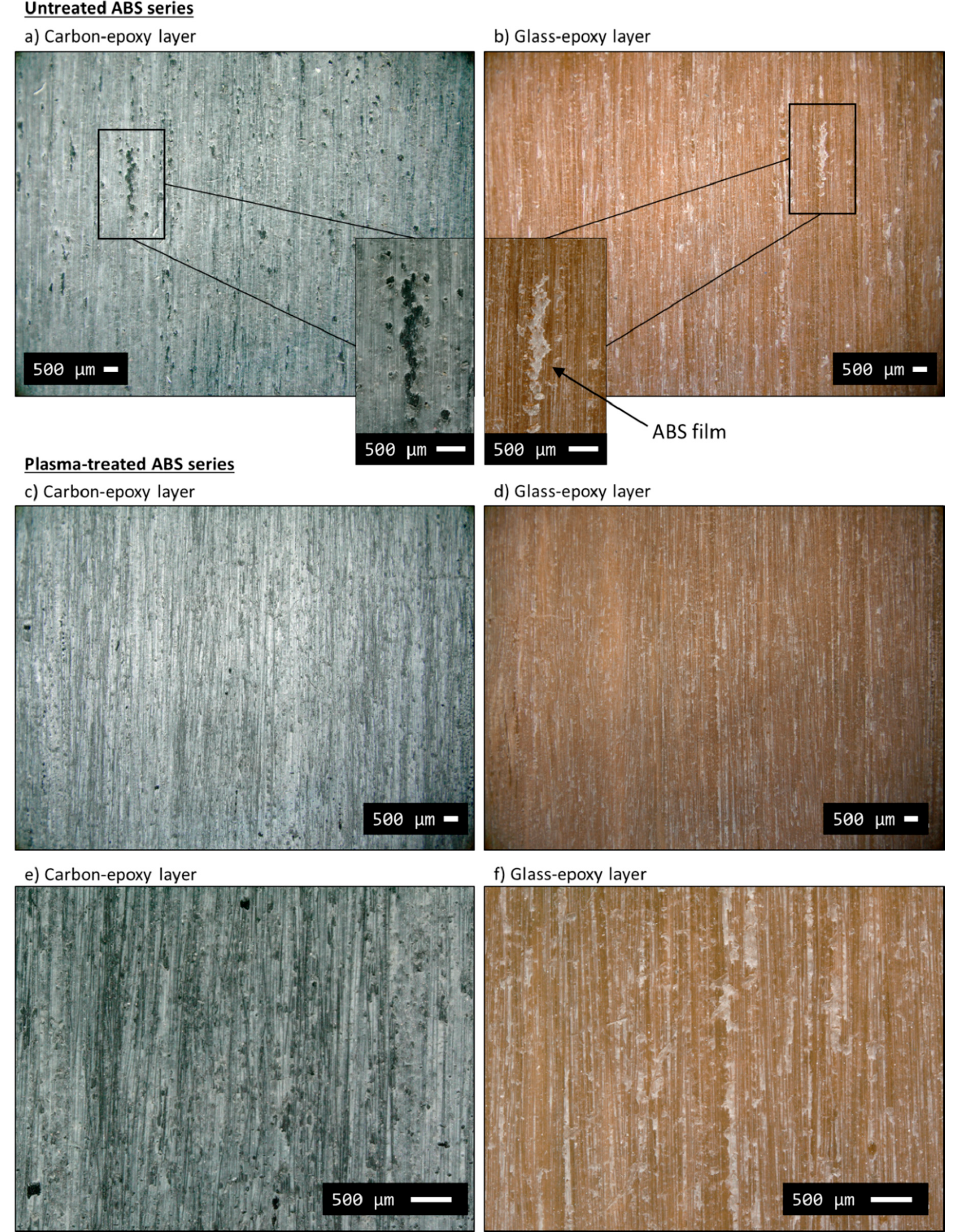
Figure 9. Delaminated surfaces of typical samples from the ABS ( a , b ) and the plasma-ABS series (from ( c ) to ( f )) analysed with digital microscope.